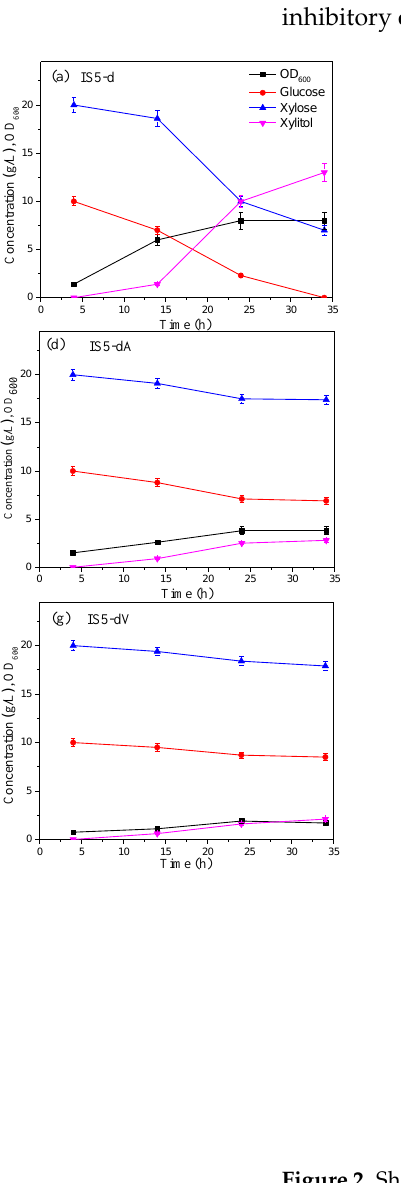
Figure 2. Shake flask fermentation by the starting strain IS5-d ( a ) and various strains ( b – j ) constructed via site-directed mutagenesis for xylitol production from corncob hydrolysate without lime treatment. ( a ) For the starting strain, IS5-d, the OD600 peaked at 9.4 at 24 h, and the maximum xylitol concentration was 15 g/L at 34 h. For ( b ) IS5-dI, ( c ) IS5-dL, ( d ) IS5-dA, ( e ) IS5-dF, ( f ) IS5-dM, ( g ) IS5-dV, and ( h ) IS5-dP, the maximum OD600 did not exceed 4.0 and less than 4.7 g/L of xylose was converted to xylitol. Additionally, most of the glucose was not consumed. ( i ) Strain IS5-dW consumed 7 g/L of glucose and converted 12 g/L of xylose to xylitol, with a maximum OD600 of 6.6. ( j ) Strain IS5-dG produced 19 g/L of xylitol within 34 h, with no residual glucose detected, and the OD600 was 11.6 at 24 h. Individual plots are presented in Figures S1 – S3 in the Supplementary Materials.